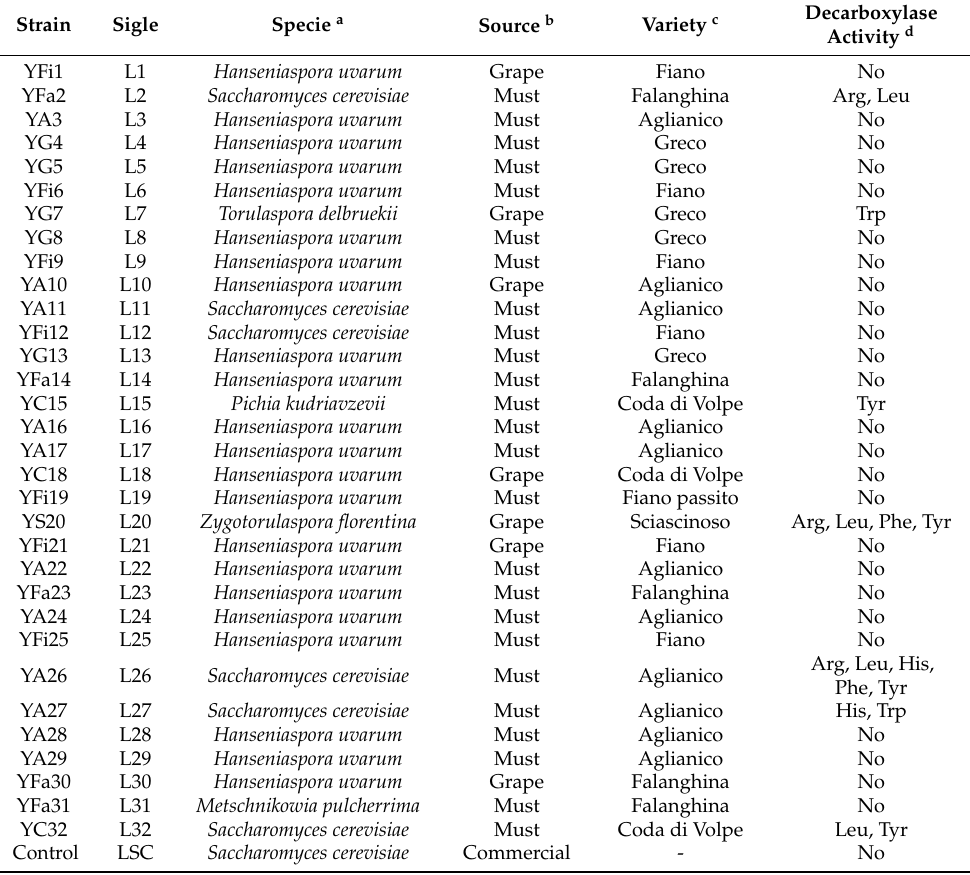
Table 1. The sources of isolation of the yeast strains and the results of the decarboxylase